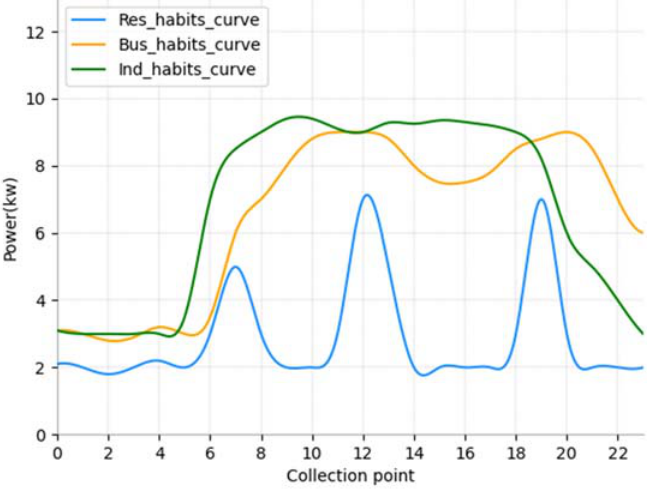
Figure 7. Customer electricity consumption habit curve.